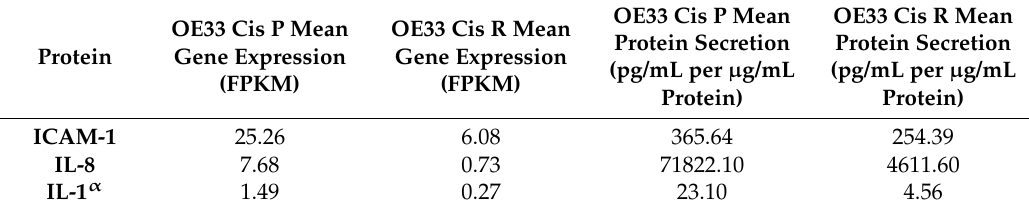
Table 2. Differences in gene expression and protein secretion values of ICAM-1, IL-8, and IL-1 α in OE33 Cis P and OE33 Cis R cells. This table shows the mean values of data that were used to calculate the significant differences in gene expression and protein secretions previously illustrated in Figures 3B and 4G, 4N, 4P. Fragments Per Kilobase of transcript per Million mapped reads (FKPM). OE33 Cis P Mean OE33 Cis R Mean Protein Gene Expression Gene (FPKM)